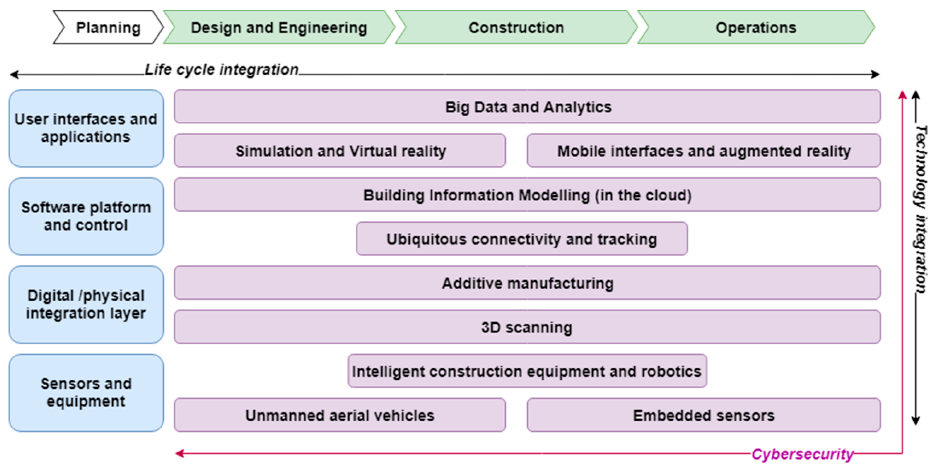
Figure 2. Digital Technologies Applied in the E&C Value Chain (Source: BSG Analysis).